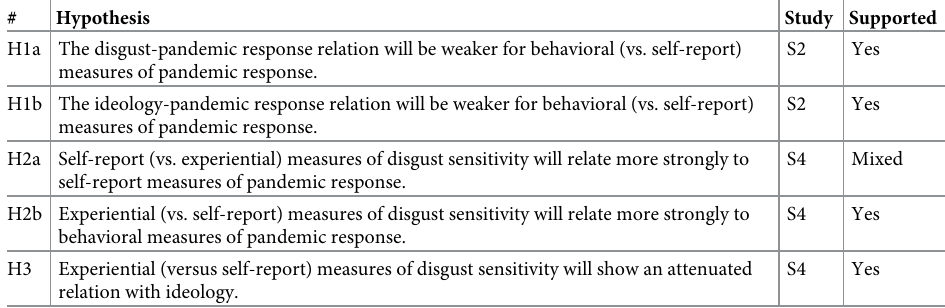
Table 3. List of hypotheses, the study in which each hypothesis was tested, and whether or not each hypothesis was supported.